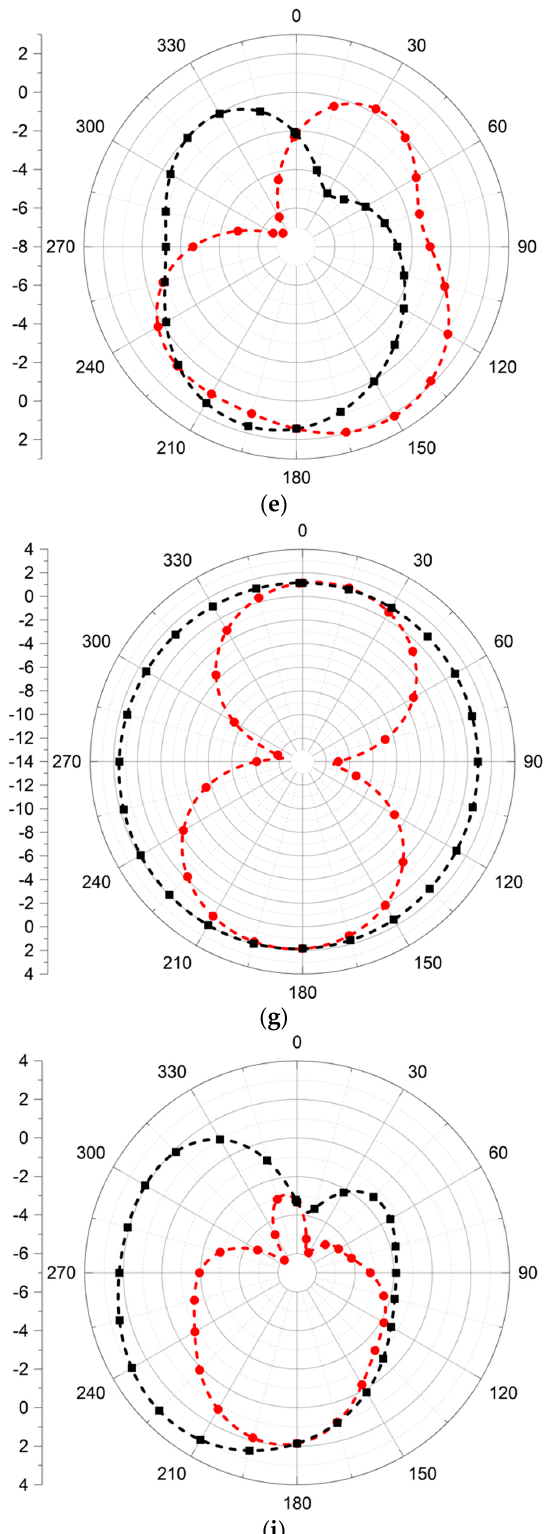
Figure 10. Simulation results of the radiation pattern of the proposed antenna at different frequencies and switching states; ( a ) 4.36 GHz (MODE 1), ( b ) 7.78 GHz (MODE 1), ( c ) 3.56 GHz (MODE 2), ( d ) 6.89 GHz (MODE 2), ( e ) 3 GHz (MODE 3), ( f ) 6.2 GHz (MODE 3), ( g ) 2.88 GHz (MODE 4), ( h ) 5.87 GHz (MODE 4) and ( i ) 8.17 GHz (MODE